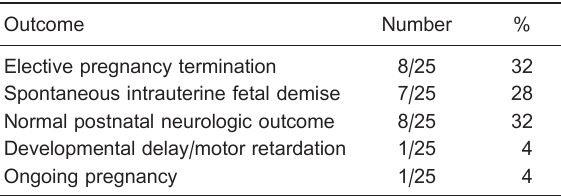
Table 3. Outcome of fetuses with septated cystic hygroma and normal karyotype morphology (n=25).